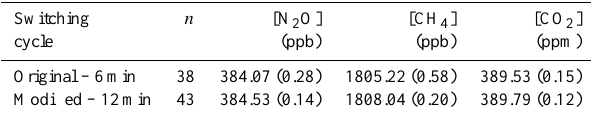
Table 1. Results of repeated mole-fraction measurements, with the FTIR spectrometer, of air from a gas cylinder with near-ambient composition (quality control). The two switching cycles are de- scribed in Sect. 2.2.1. Numbers in parentheses are standard devi- ations, from n successive cell